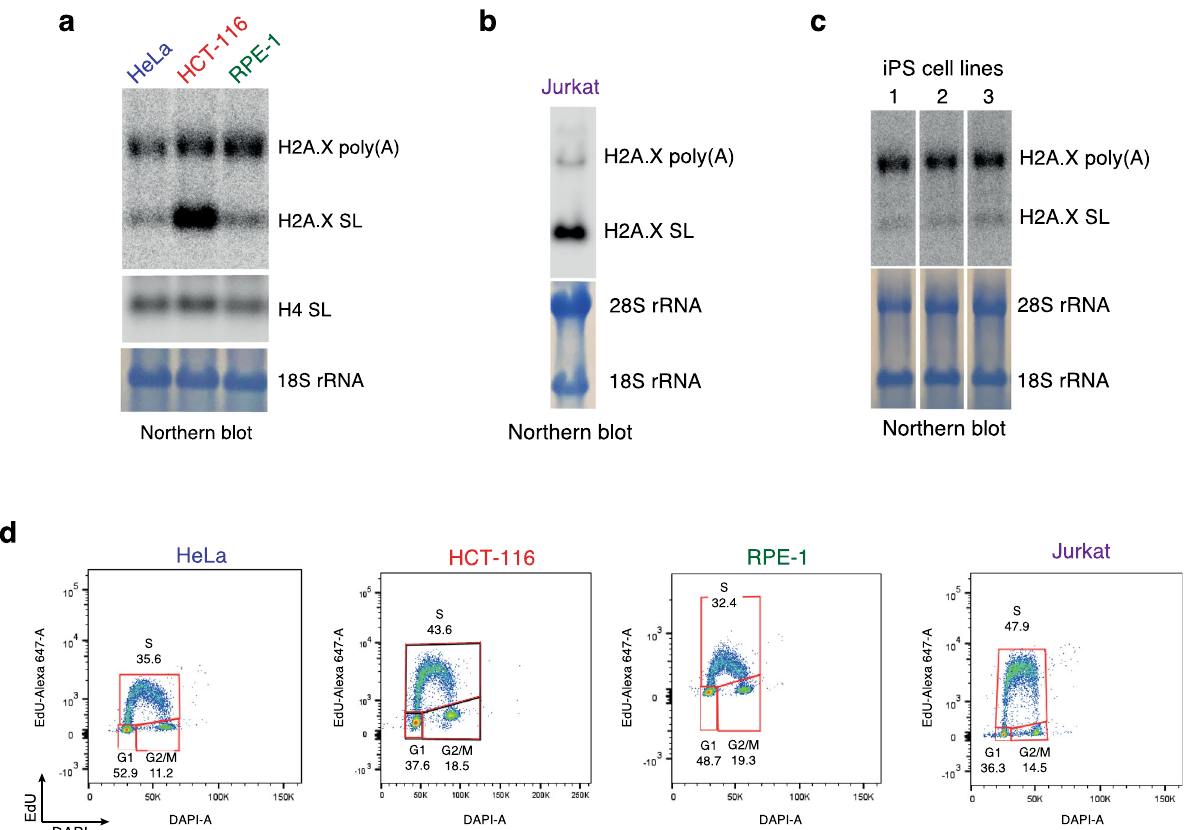
Fig. 2 H2AFX expresses both H2A.X poly(A) and SL mRNA isoforms. a H2A.X mRNA northern blot of total RNA from asynchronous HeLa, HCT-116 and RPE-1 cells. H4 SL: core H4 histone SL mRNA. 18S rRNA used as loading control. b H2A.X mRNA northern blot of total RNA from asynchronous Jurkat cells. 28S and 18S rRNA used as loading controls. c H2A.X mRNA northern blot of total RNA from three different human iPS cell lines. 28S and 18S rRNA used as loading controls. d EdU labelling of asynchronous HeLa, HCT-116, RPE-1 and Jurkat cells showing DAPI fl uorescent intensity on x-axis and Alexa 647-EdU fl uorescent intensity on